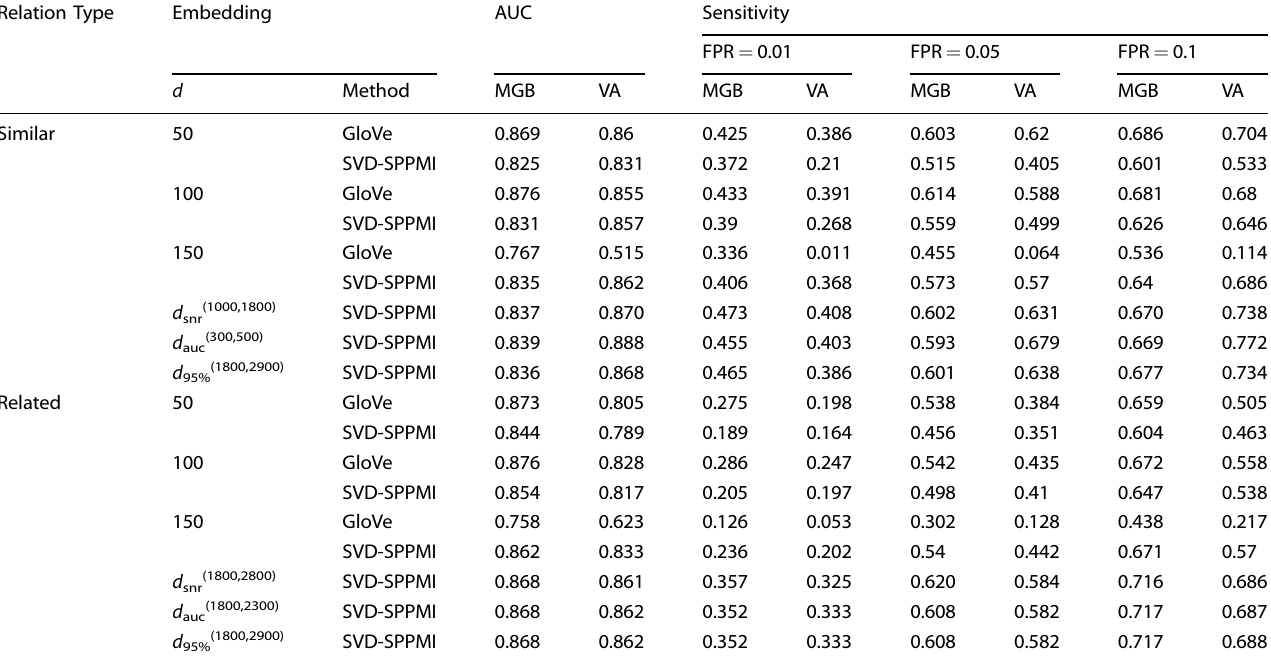
Table 1. AUCs and sensitivity at FPR = 0.01, 0.05, and 0.10 of between-vector cosine similarity in detecting known similar pairs (RxNorm-RxNorm and Lab-Lab) and related pairs (PheCode-PheCode; PheCode-RxNorm) with embeddings trained via SVD-SPPMI or GloVe at different choices of dimensions d